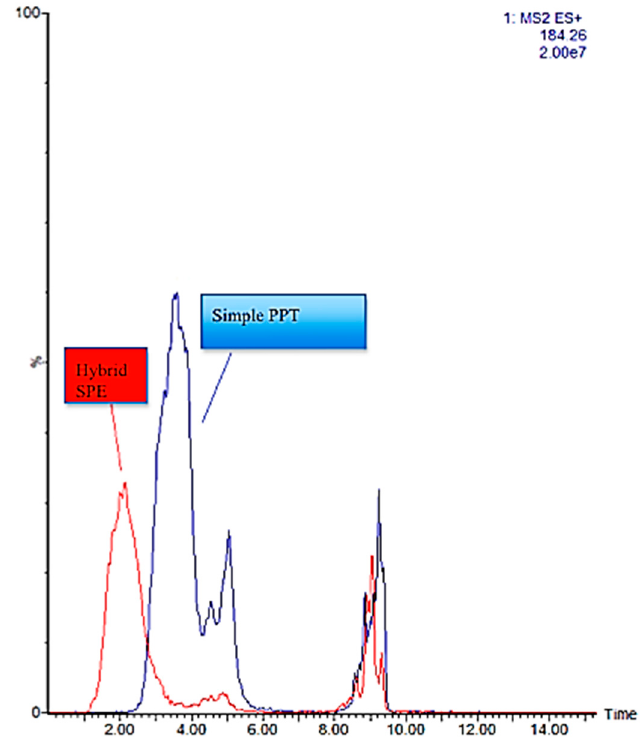
Figure 5. Overlay extracted ion chromatograms ( m / z 184) from full scan analysis of samples after PPT and HybridSPE procedures.